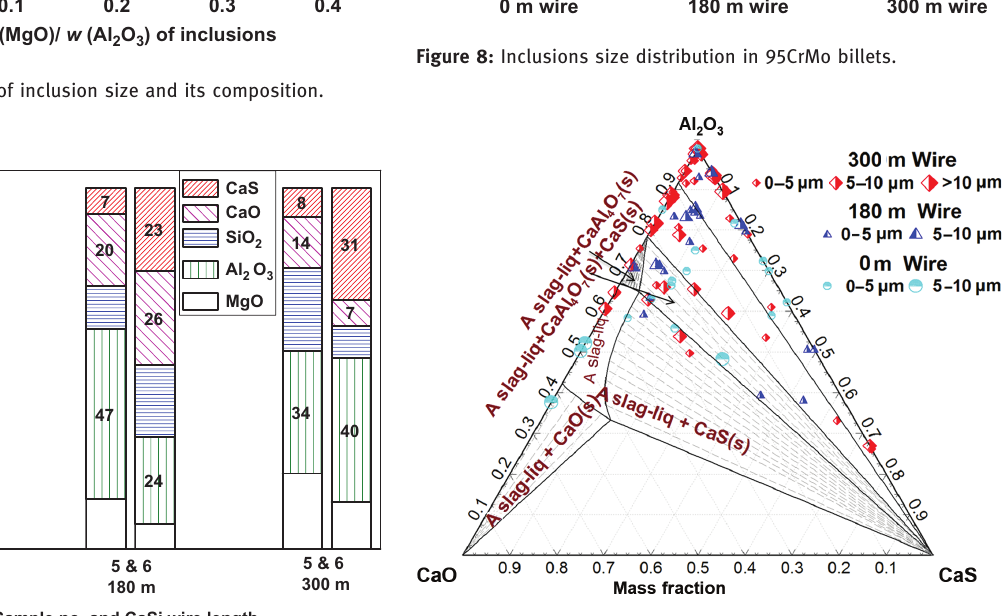
Figure 9: Inclusions distribution in billets and Al 2 O 3 – CaO – CaS ternary plot at 1,873 K.